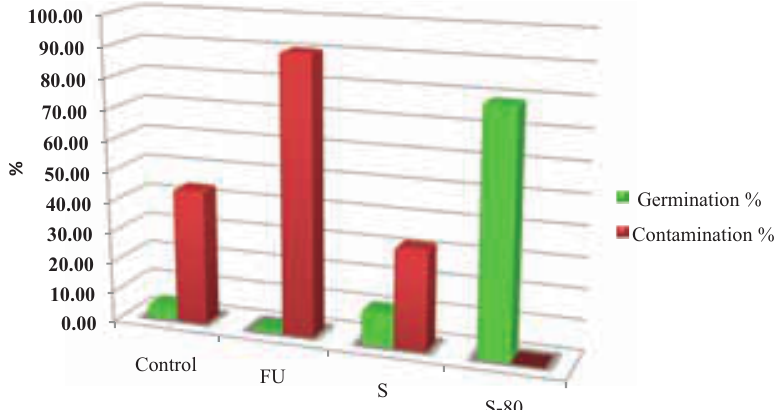
Figure 1. Germination and contamination pattern of water-fractionated seeds with or without HWT priming FU: Floated seeds/supernatant fraction S-80: sunk seeds/ imbibed fraction under 80 o C hot water treatment; S: sunk but not treated seeds; Control: not fractionated, soaked in destillited water in room temperatupe Table 1. Germination and contamination pattern of water-fractionated seeds with or without HWT priming (50 pcs seeds per each treatment) Treatment